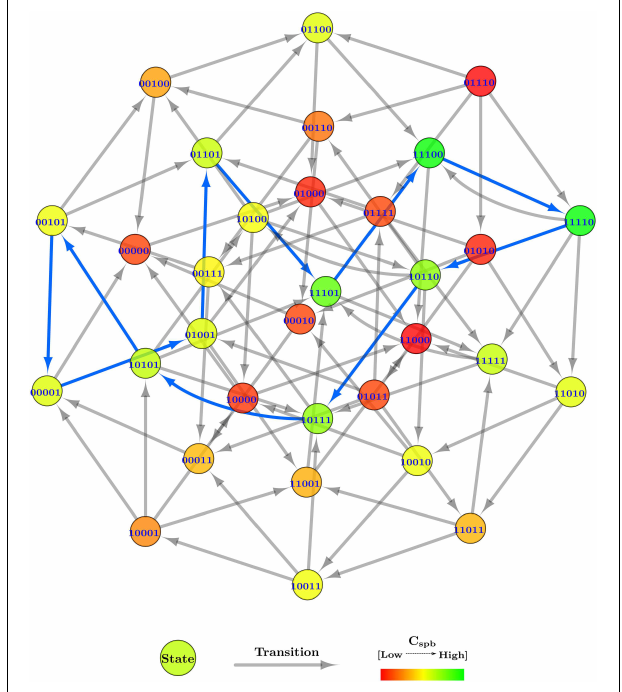
FIGURE 8 | Centrality applied state graph of Case Study 2: Atmospheric system. The cycle selected for hybrid modeling is shown via blue state